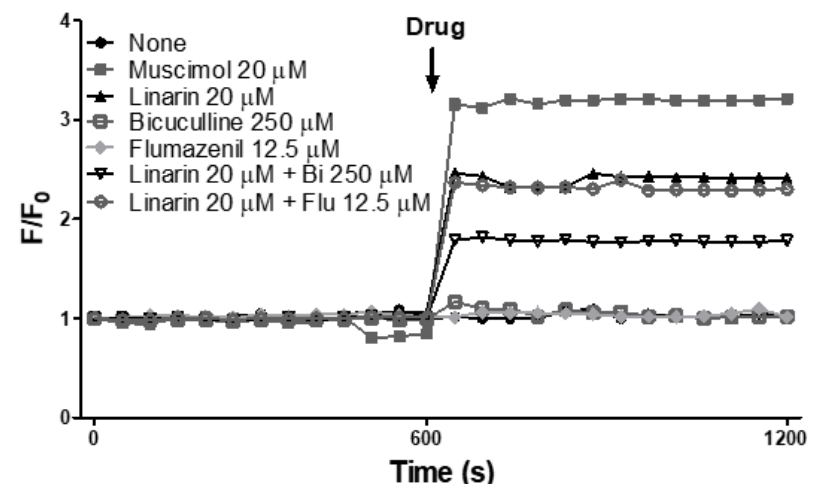
Figure 6. Linarin shows Cl − influx in human neuroblastoma cells (SH-SY5Y) in vitro. Cells were incubated with 5 mM N-(Ethoxycarbonylmethyl)-6-Methoxyquinolinium Bromide (MQAE) for 3 h and then treated with 500 µ M bicuculline or 12.5 µ M flumazenil for 15 min. Fluorescence was monitored using excitation at 365 nm and emission at 450 nm. Contents of influxed Cl − ion were expressed as a peak (F/F 0 ).